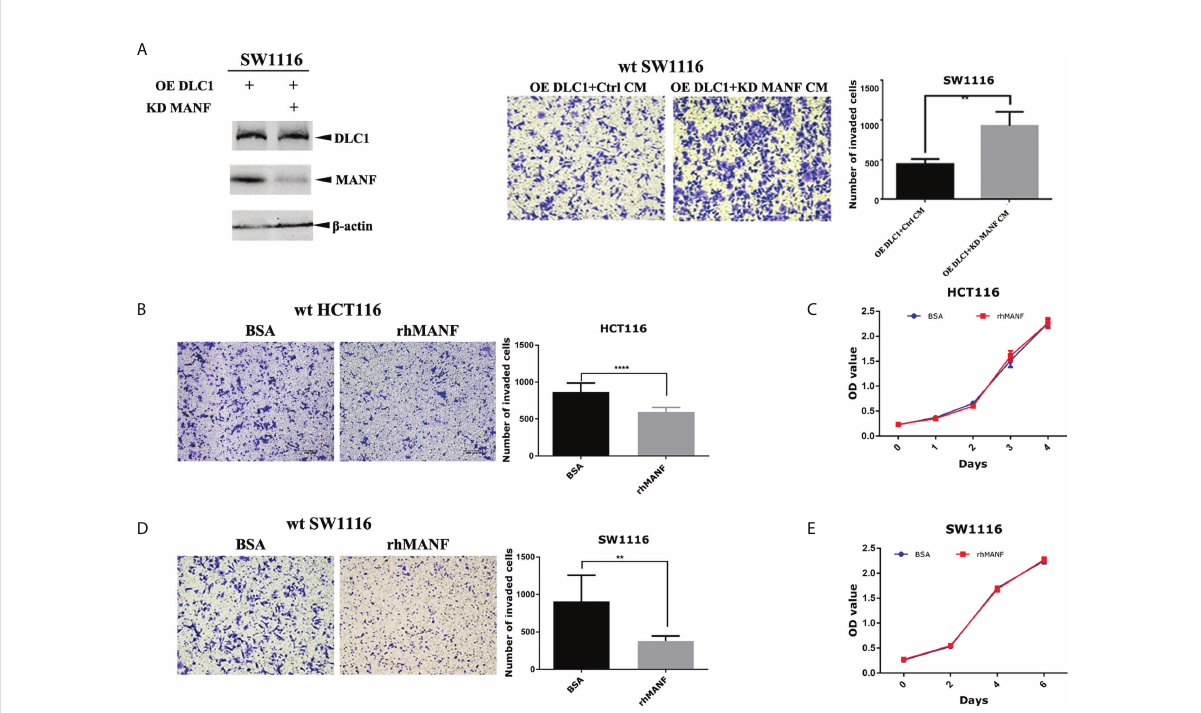
FIGURE 3 DLC1 inhibited colon adenocarcinoma cell migration depending on MANF. (A) We knocked down MANF expression by using speci fi c shRNA in stable DLC1-expressed SW1116 cells. It was veri fi ed by Western blot. The ability of these cells to migrate increased as the MANF expression decreased. The concentration of CM added in the upper chamber was 1 m g/ml. ** p < 0.01, compared with the vector group. (B – E) In comparison with negative control (same concentration of BSA), wild-type SW1116 and HCT116 treated with 200 ng/ml recombinant MANF decreased the ability to migrate, but recombinant MANF had no effect on proliferation. ** p < 0.01, **** p < 0.0001 compared with the vector